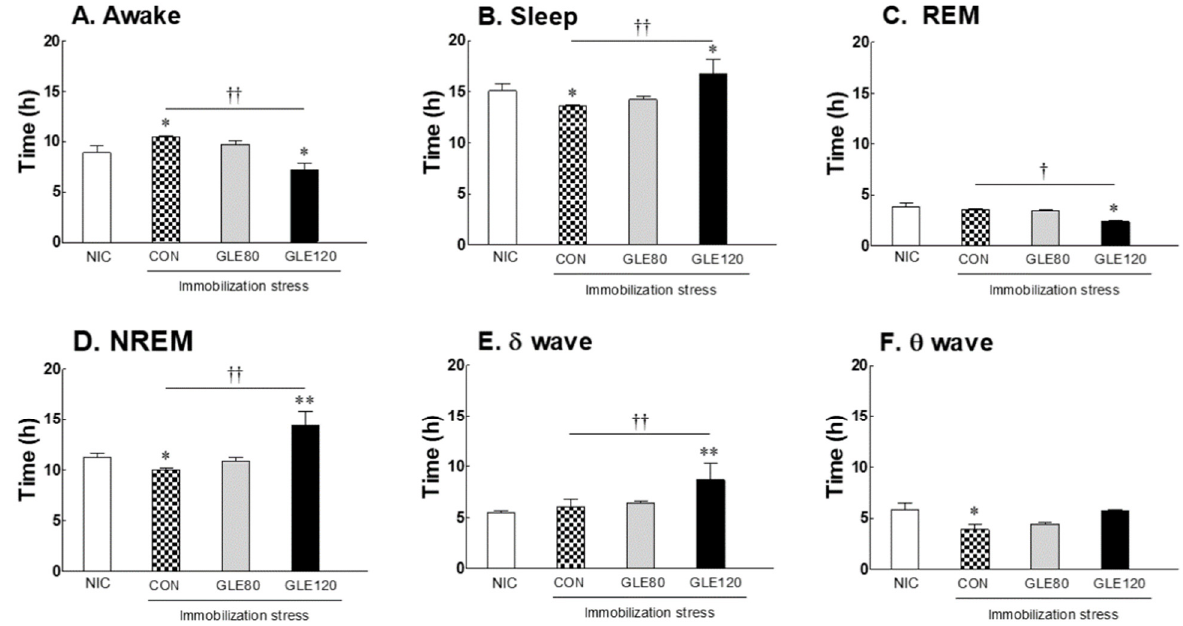
Figure 3. Effects of GLE (green lettuce leaf extract) on ( A ) awake, ( B ) sleep, ( C ) REM, ( D ) NREM, ( E ) δ -wave, and ( F ) θ -wave sleep pattern changed by immobilization stress in rats. EEG analyses were conducted for nine days, and GLE was administered orally. Experimental groups include the no-immobilization-stress control group (NIC), control group (CON, stress-induced immobilization), and GLE (green lettuce leaf extract)-treated groups with stress (80 and 120 mg/kg). Values are presented as the mean ± standard error of the mean (SEM) for each group, n = 8. * p < 0.05 and ** p < 0.01 when compared with the NIC group. † p < 0.05 and †† p < 0.01 when compared with the CON group (ANOVA followed by post-hoc Tukey’s test).